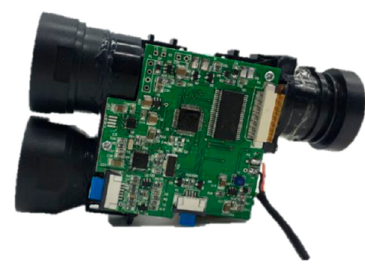
Figure 10. Laser Ranger LRF 28-2000B.